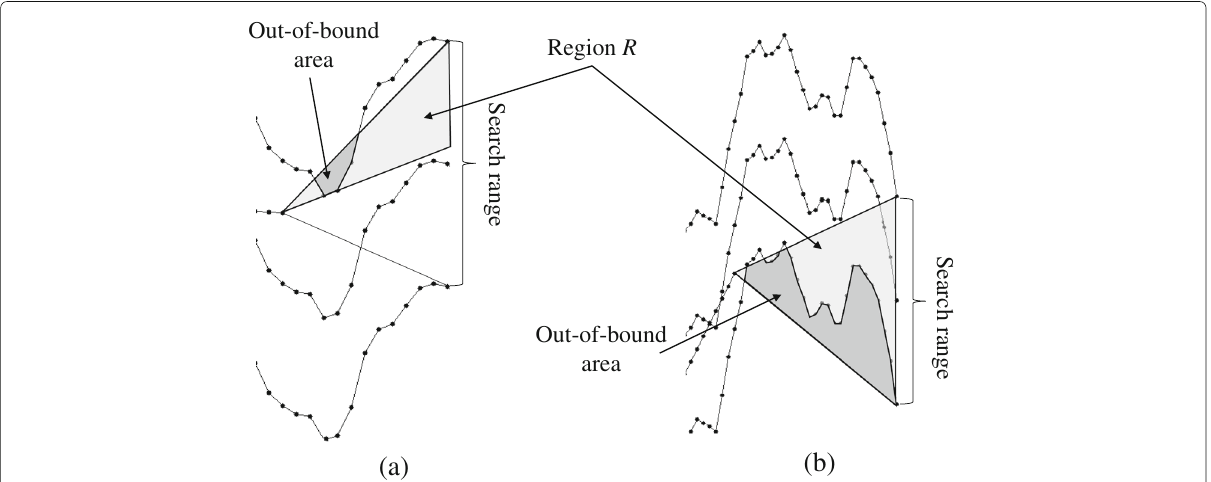
Fig. 7 a Some and b all candidate lines pass through an out-of-bound area. None of these candidate lines should be chosen as the best line